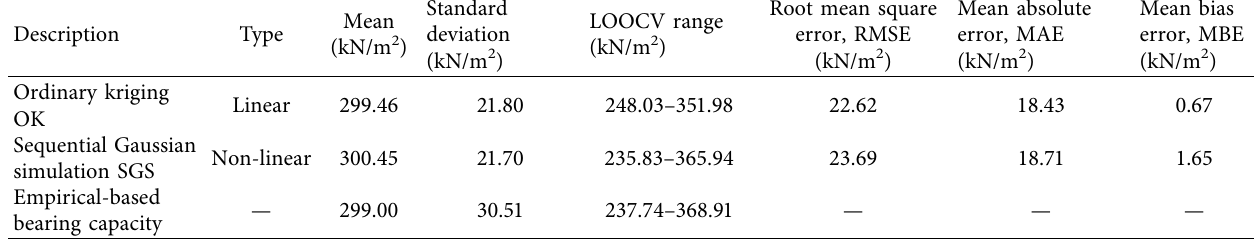
Table 2: Summary statistics and metrics of accuracy from OK and SGS LOOCV.